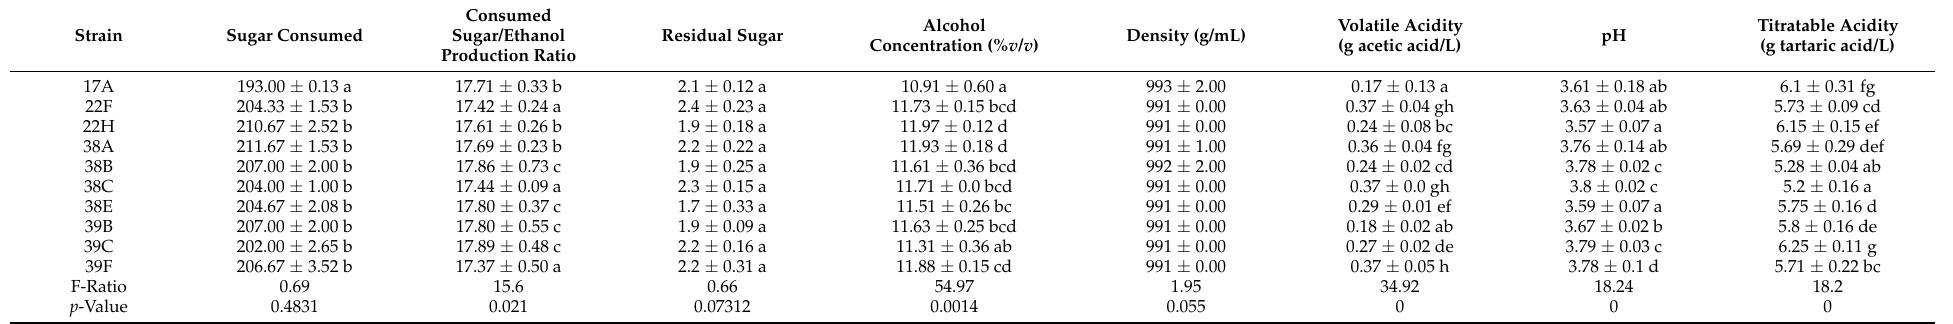
Table 2. Effect of fermentation with selected yeast on the sugar consumed during fermentation, the consumed sugar/ethanol production ratio and the Garnacha wine